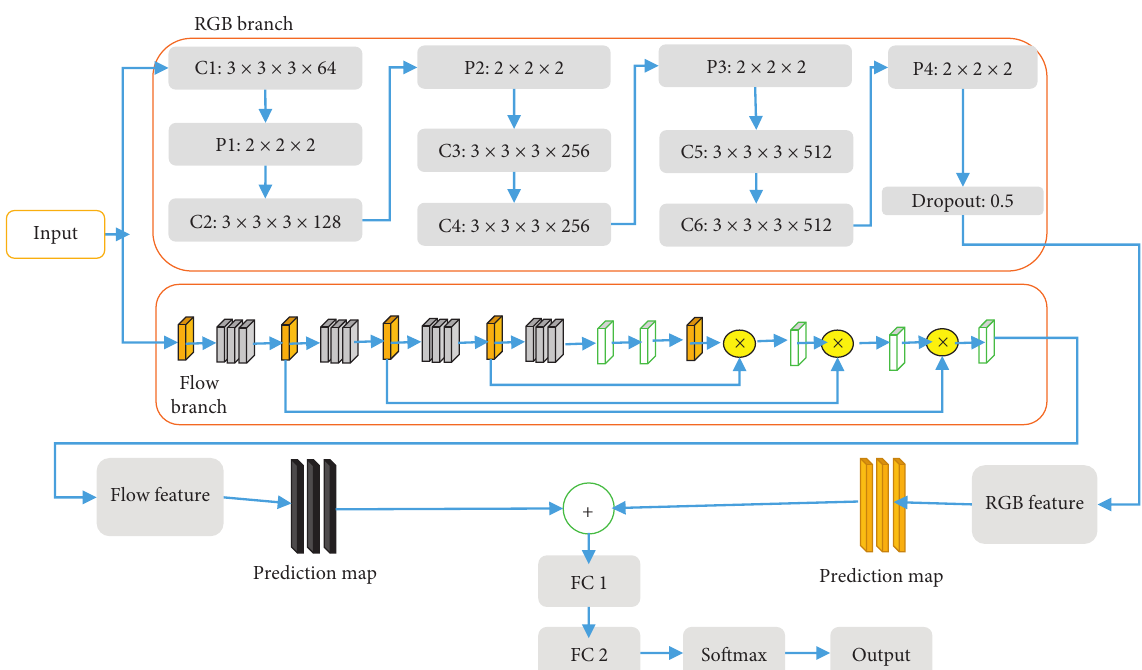
Figure 3: Improved fusion multichannel 3D convolutional neural network structure.